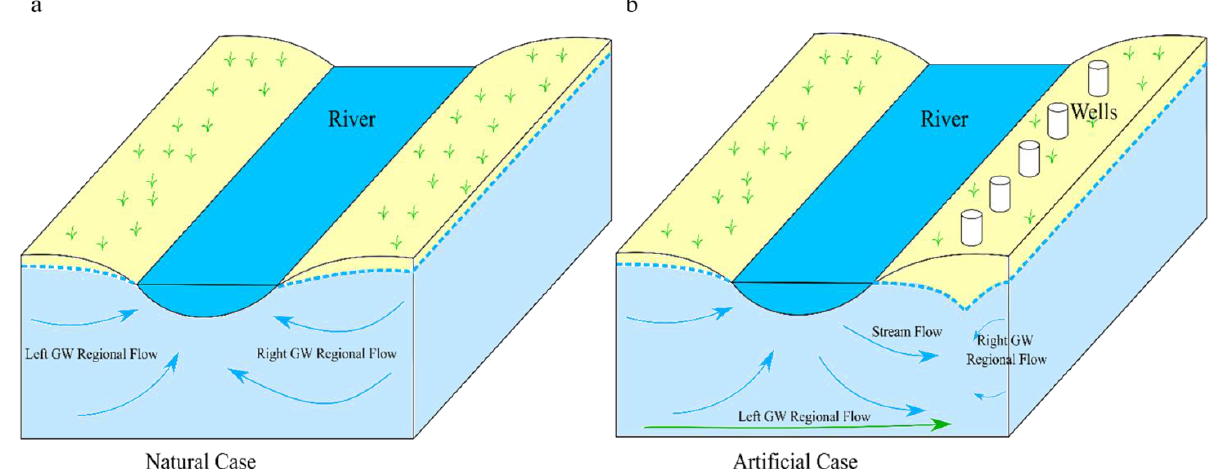
Figure 2. Schematic view of the modeling base situation with two main variations: ( a ) the natural gaining river, ( b ) the river variation with a pumping field.